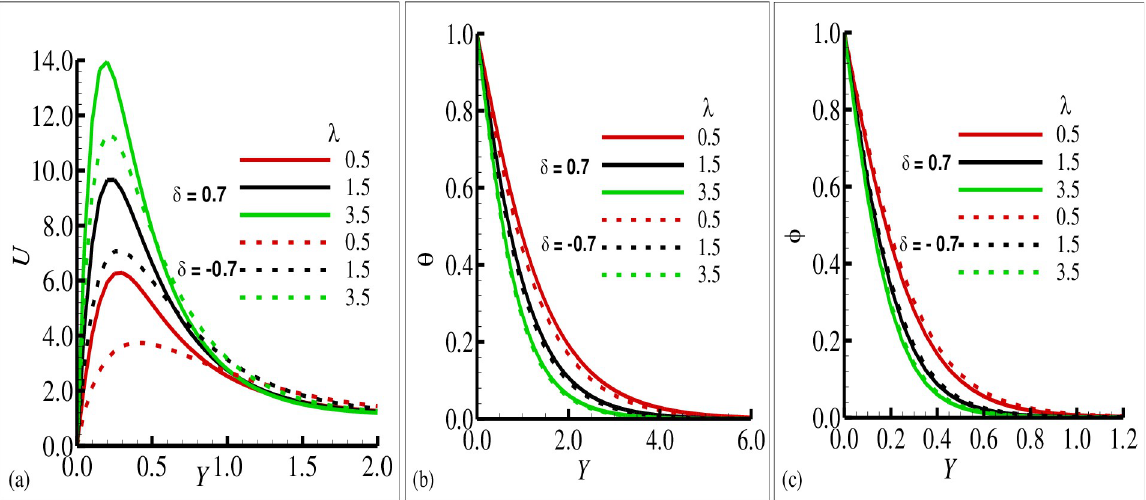
Fig 4. The graphical results for (a) velocity field u , (b) temperature field θ , and (c) magnetic field ϕ with the choice values of λ = 0.5, 1.5, 3.5 for heat source δ = 0.7 and sink δ = − 0.7, where others are γ = 0.3, O = 0.06, ξ = 0.7 and Pr = 7.0.